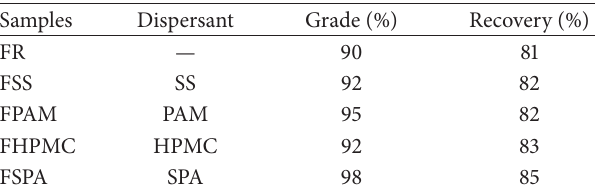
Table 1: The effect of dispersants on the concentrate grade and . recovery of CaF 2